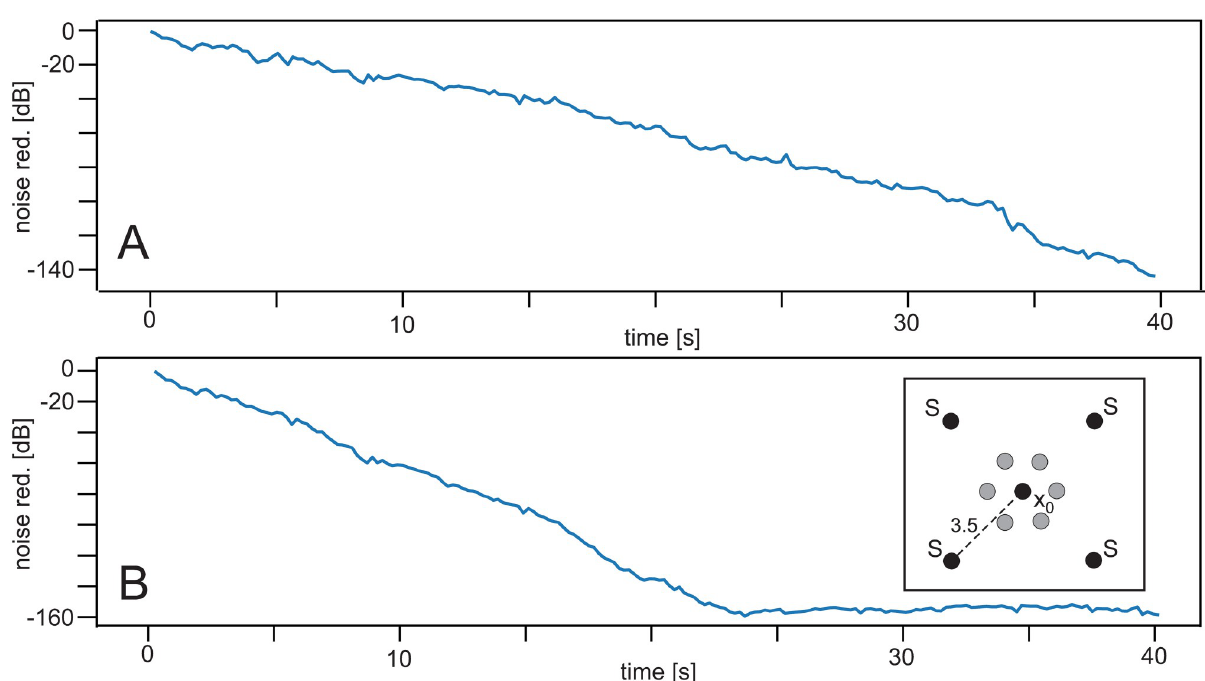
Fig 7. Effect of using the momentum. Learning rate: μ = 7.5 × 10 − 8 . Configuration is shown as inset in panel B. It contains a similar shielding as in Fig 6, which for clarity, is not drawn. Distance from S to x 0 was 3.5 m . A Using the original ICO rule, B Using the rule with momentum.